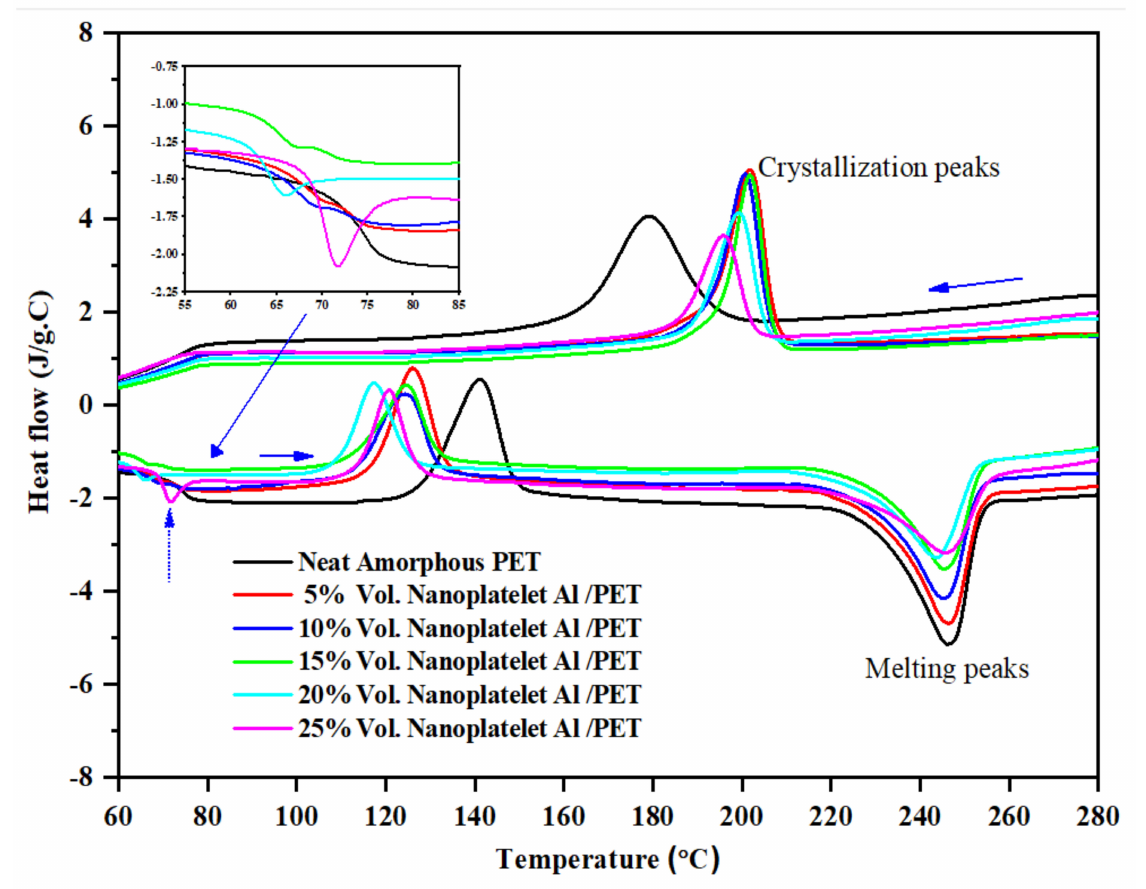
Figure 6. First DSC cycle curves at 10 ◦ C/min. The bottom curve is for heating of the amorphous PET and the Al platelet/amorphous PET composites. The inset (arrow) shows expansion of the enthalpy relaxation peak at the T g , seen in the heating curves (vertical arrow), due to physical ageing of the samples. The T g was, therefore, measured from the cooling curves